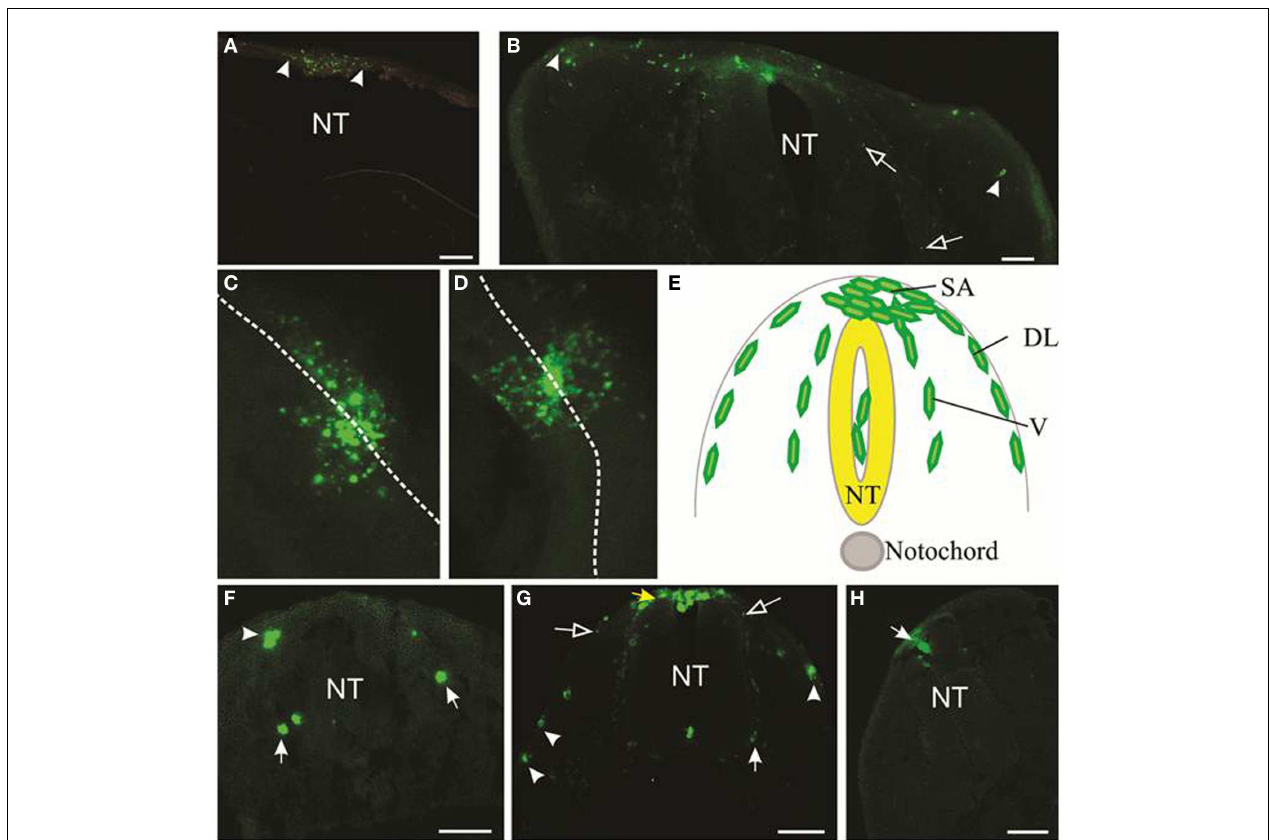
Melanoma cells are injected into the lumen of the neural tube (NT) and some remain in this position without migrating. Cells emerge from the neural tube at the dorsal surface (top) into the staging area (SA).They then migrate along one of two major pathways: the dorsolateral pathway under the ectoderm (DL) or the ventral pathway (V). (F,G) Cross-sections of trunk at 2 DPI showing the location of (F) LM-MEL-3 and (G) LM-MEL-8 cells. Cells can be seen along dorsolateral (arrowheads) and ventral (arrows) pathways.The SA is indicated with a yellow arrow in (G) . (H) Melanocyte cells are found in the roof of the neural tube (arrow) but very few migrate outside the neural tube. NT, neural tube. Scale bar is 100 µ m. Open arrows indicate speckles of DiO that have transferred to non-melanoma